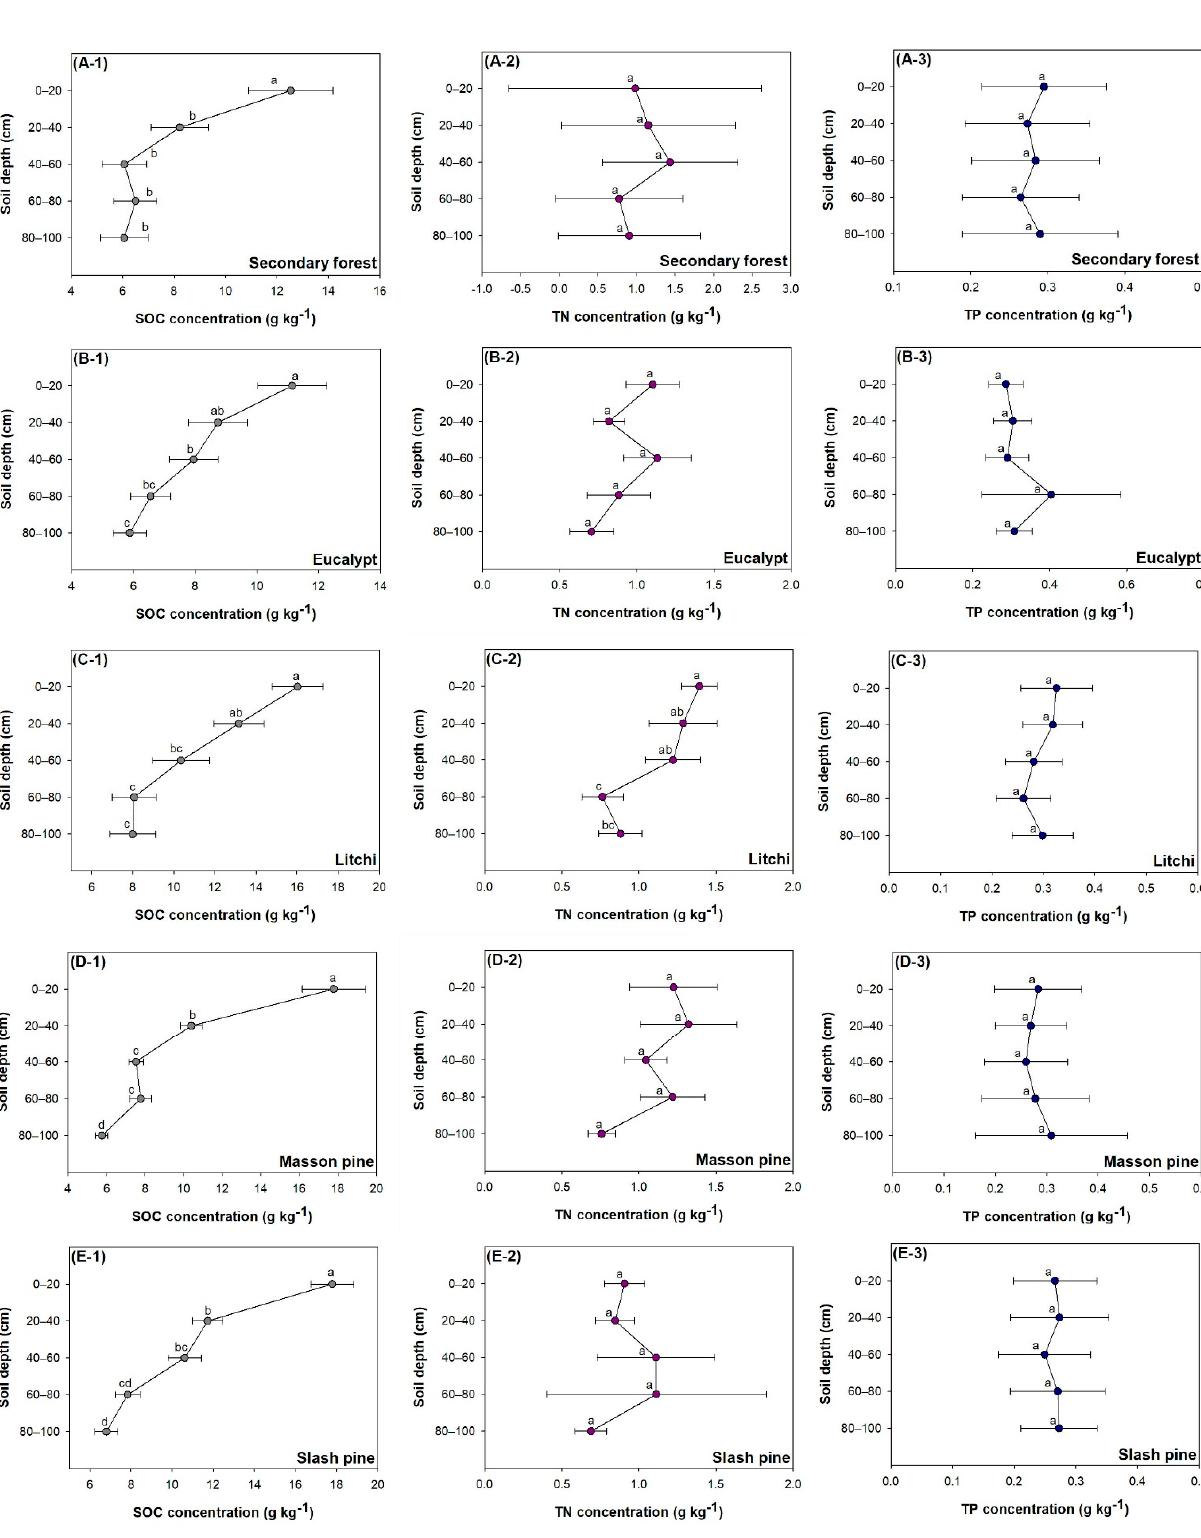
Figure 4. Differences of concentrations in soil organic carbon (SOC) ( A-1 , B-1 , C-1 , D-1 , E-1 ), total nitrogen (TN) ( A-2 , B-2 , C-2 , D-2 , E-2 ), and total phosphorus (TP) ( A-3 , B-3 , C-3 , D-3 , E-3 ) in five soil layers at depths of 0–20 cm, 20–40 cm, 40–60 cm, 60–80 cm, and 80–100 cm from stands of secondary forests and four types of plantations of Eucalypt ( Eucalyptus obliqua L’H é r.), Litchi ( Litchi chinensis Sonn., 1782), Masson pine ( Pinus massoniana Lamb.), and Slash pine ( Pinus elliottii Engelm.) in Yunfu, Guangdong province, South China. Bars indicate standard deviations. Different letters beyond bars indicate significant difference detected by paired t -test at 0.05